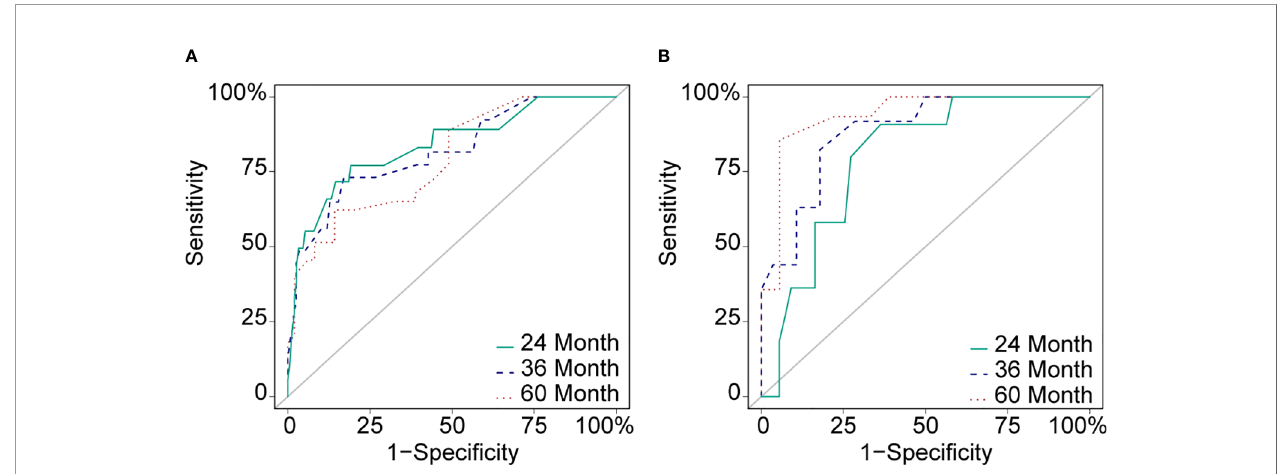
FIGURE 5 | ROC curves of the training dataset (A) and the validation dataset (B) in 24 months (AUC: 83.7% vs. 79.6%), 36 months (AUC: 81.7% vs. 88.2%) and 60 months (AUC: 79.0% vs. 93.8%).